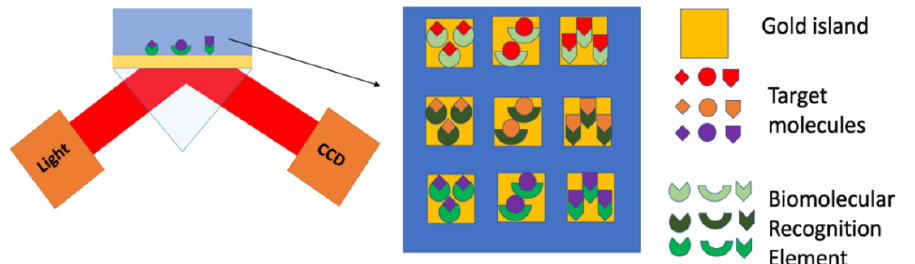
Figure 7. Illustration of the reflected light from the biorecognition event on the array being detected via a CCD camera for each array spot as the change of intensity of the reflected